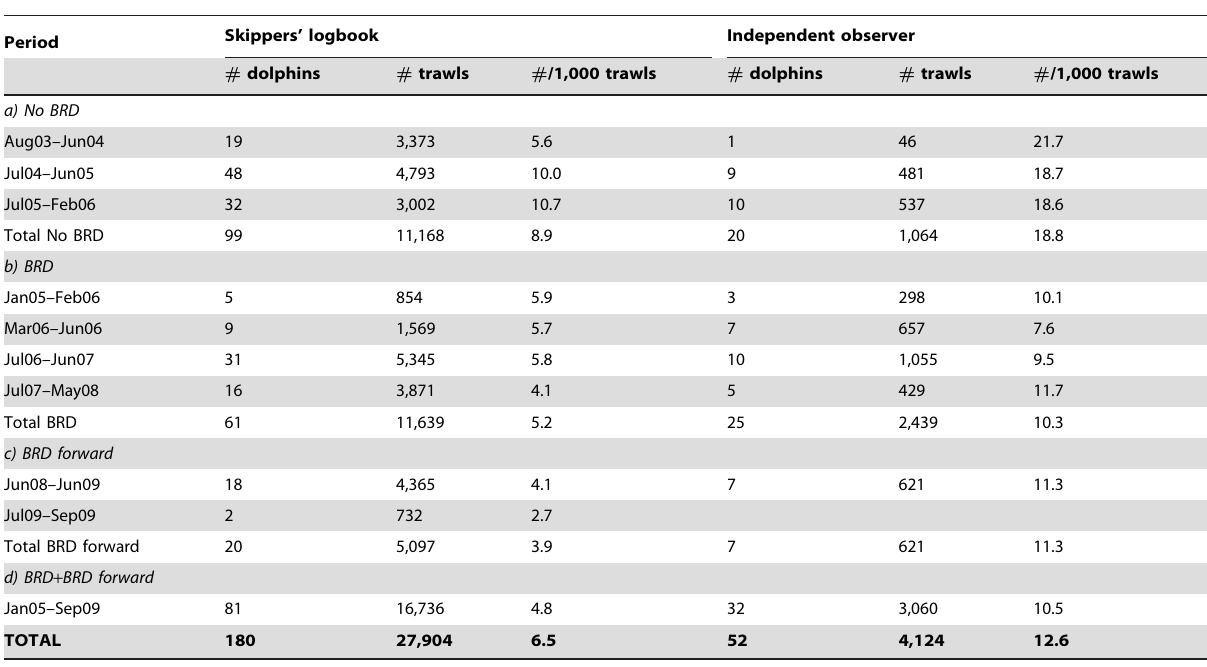
Table 2. Dolphin bycatch rates reported by skippers and observers.